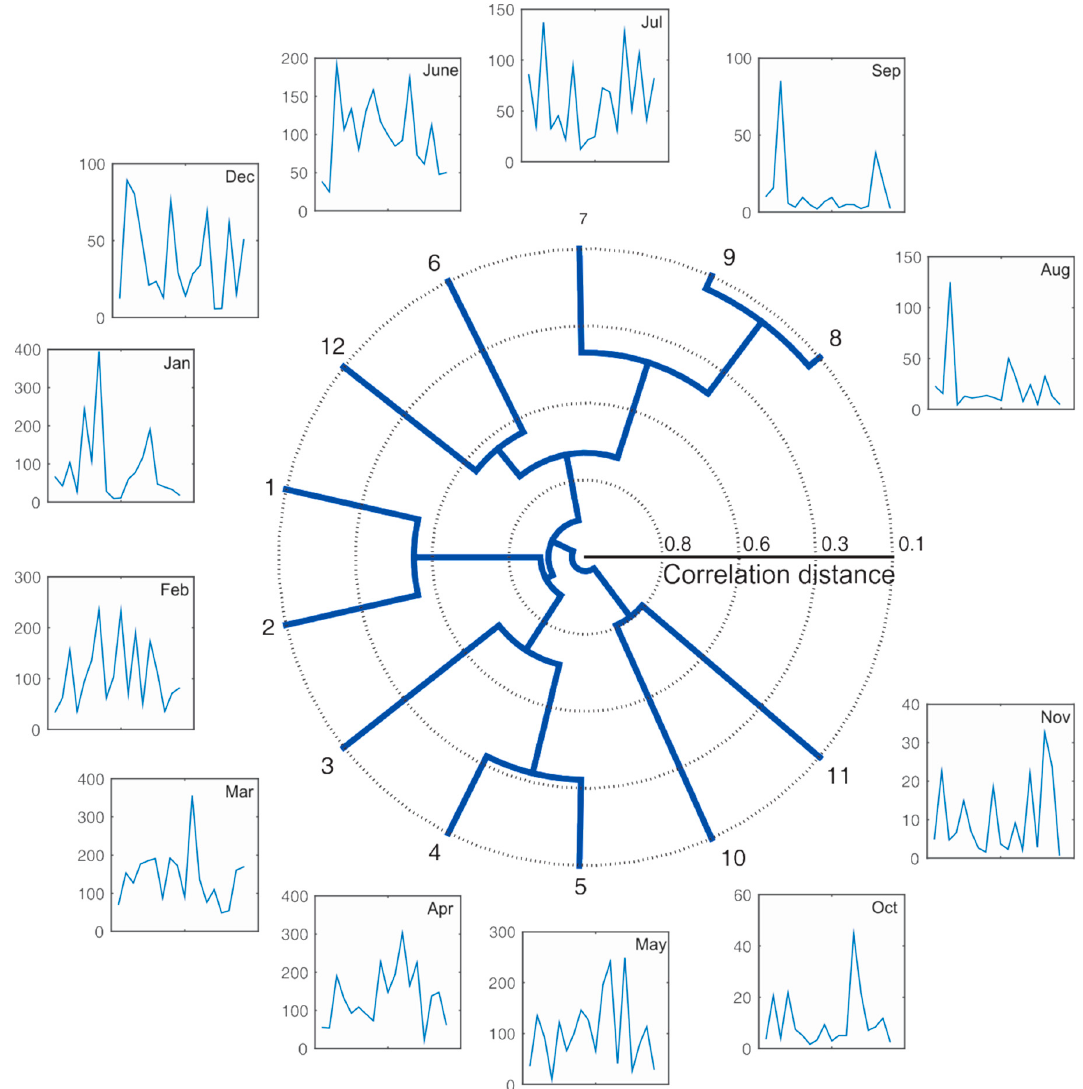
Figure 4. Dendrogram of the time series of each month from 1998 to 2015.